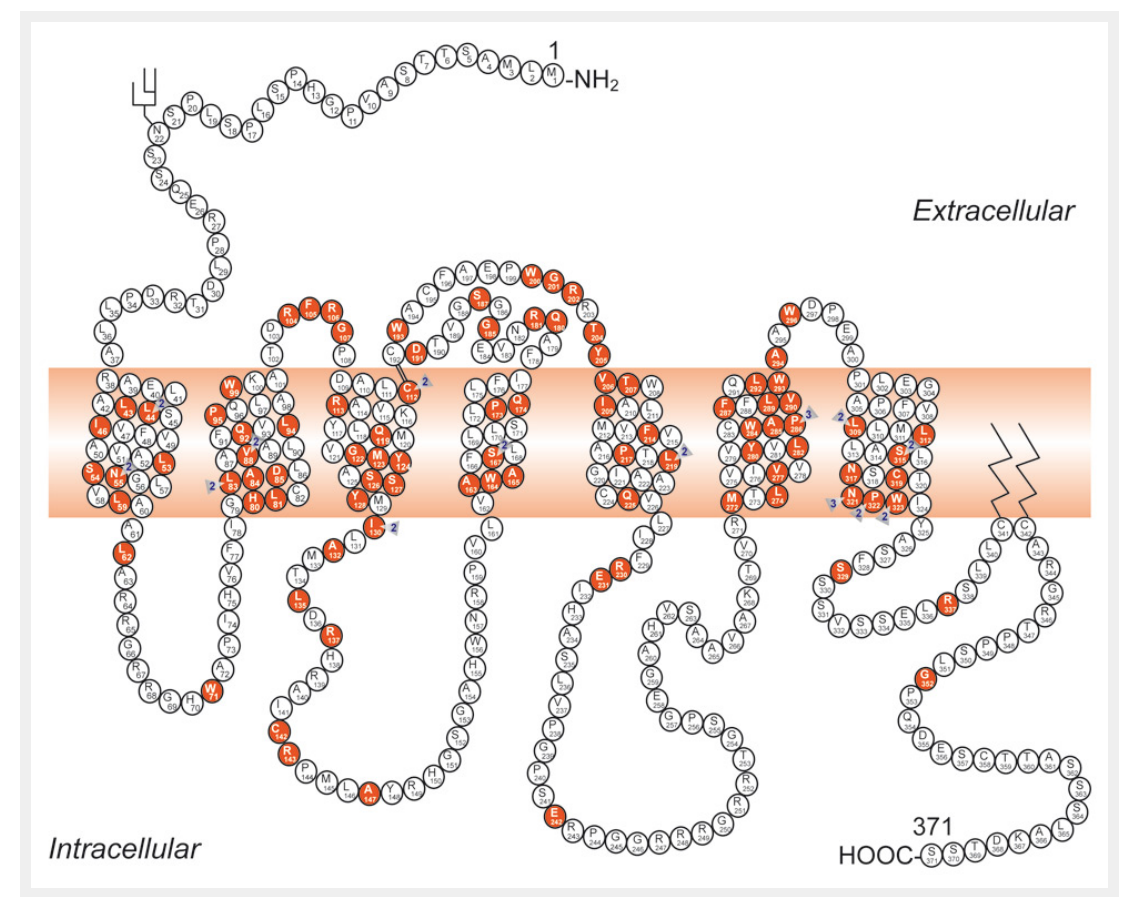
Figure 7 Schematic representation of the V 2 receptor and identification of 193 putative disease-causing AVPR2 mutations. Predicted amino acids are shown as the one-letter amino acid code. A solid symbol indicates a codon with a missense or nonsense mutation; a number indicates more than one mutation in the same codon; other types of mutation are not indicated on the figure. There are 95 missense, 18 nonsense, 46 frameshift deletion or insertion, 7 inframe deletion or insertion, 4 splice-site, and 22 large deletion mutations, and one complex mutation. (From: Bonnardeaux A, Bichet DG. Inherited disorders of the renal tubule. In: Brenner BM (ed). The Kidney. 8th ed. New York: Harcourt Health Sciences; 2008. p. 1382‒1419. © Elsevier, Oxford, UK, with kind